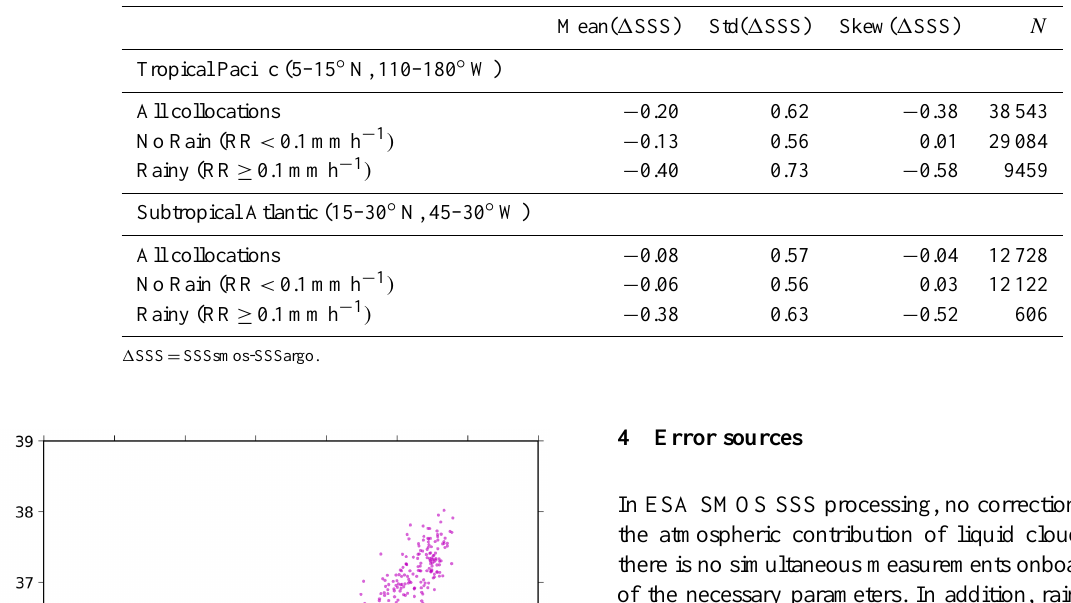
Table 2. Statistics of SMOS level 2 SSS minus ARGO SSS (matchups at ± 50km and ± 80mn from SSM/I rain rates).